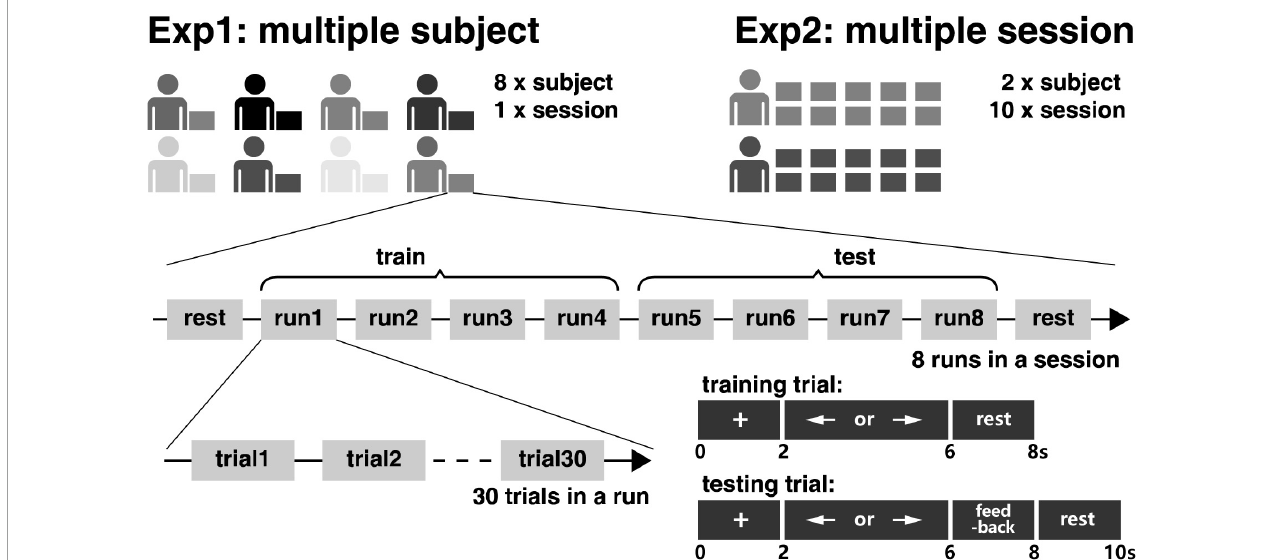
FIGURE2 The experimental